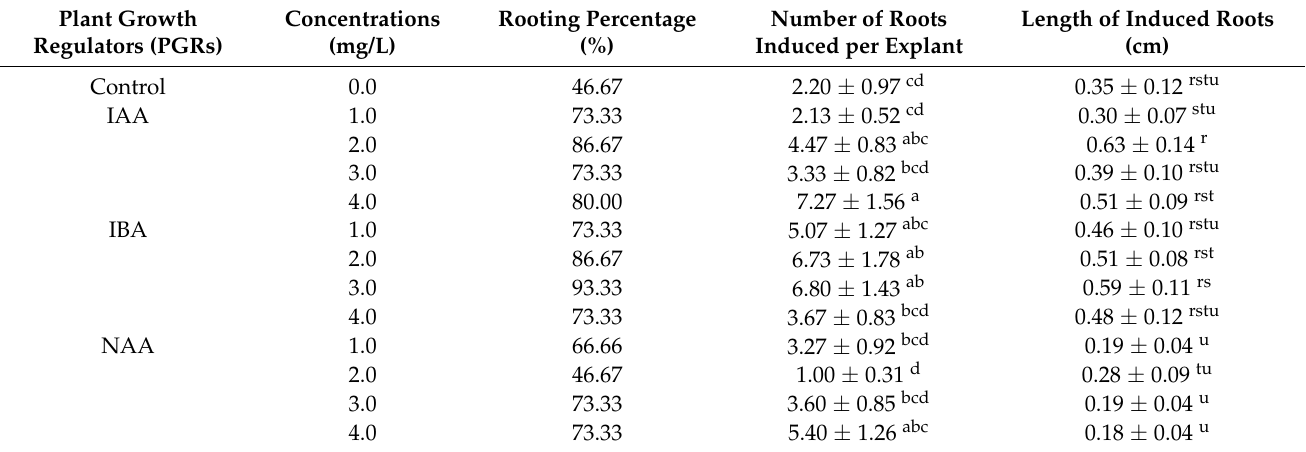
Table 2. The effects of IAA, IBA, and NAA on root regeneration after 6 weeks of